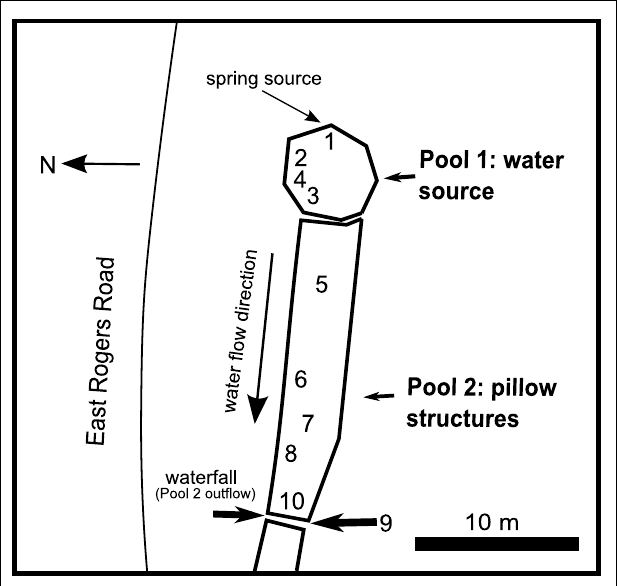
FIGURE 1 | Map of groundwater seep site in Bloomington, IN, USA. Numbers indicate sampling